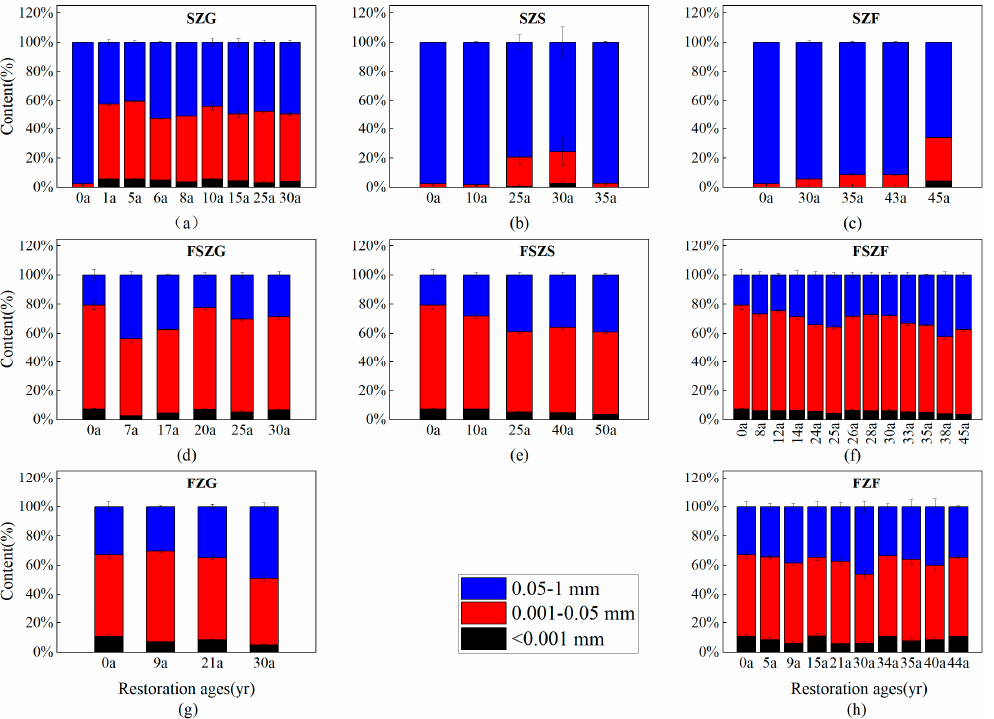
Figure 3. Changes to soil microaggregate content in di ff erent vegetation zones across the vegetation restoration chronosequence. ( a – c ) show changes to the soil microaggregate content of SZG, SZS, and SZF with restoration age, respectively; ( d – f ) show changes to the soil microaggregate content of FSZG, FSZS, and FSZF with restoration age, respectively; ( g – h ) show variation in soil microaggregate content of grassland and forests with restoration age in the forest zone, respectively. Note: values are mean ± standard